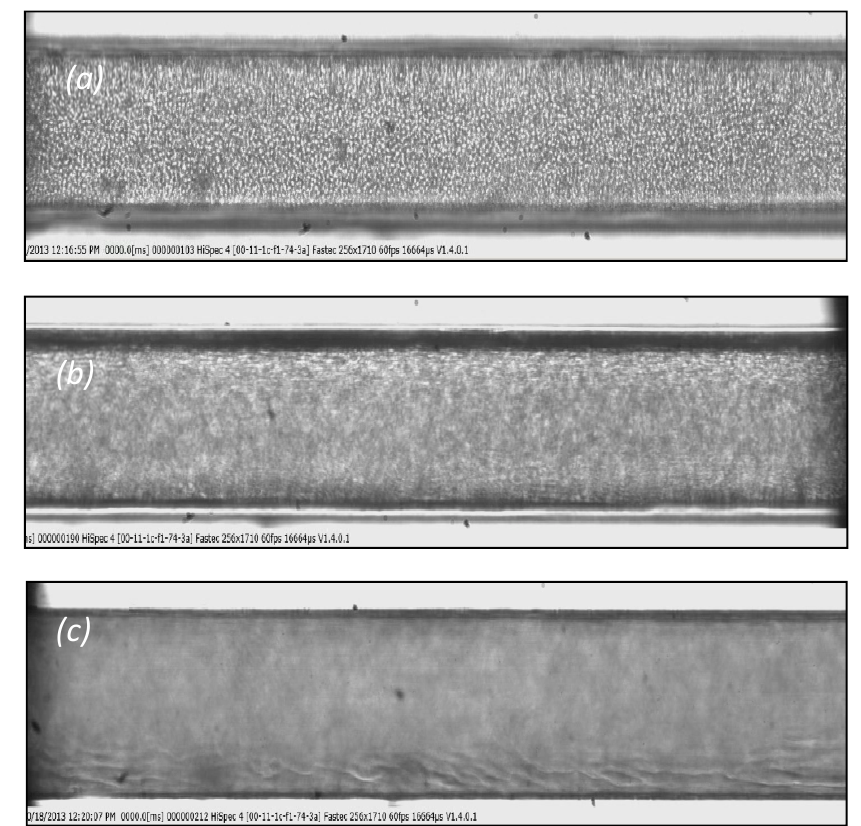
Figure 5. Typical velocity profiles for H ct = 10% for both tracing methods (microparticles vs. RBCs) employed ( D = 170 μ m, Q = 5 mL/h). Comparison shows that the RBC slip velocity is practically zero.